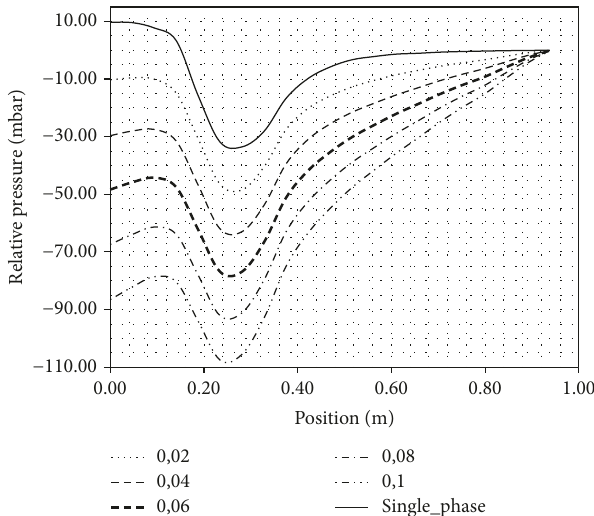
Figure 18: Pressure distribution at nominal mass flow rate for different Ar volume fractions.